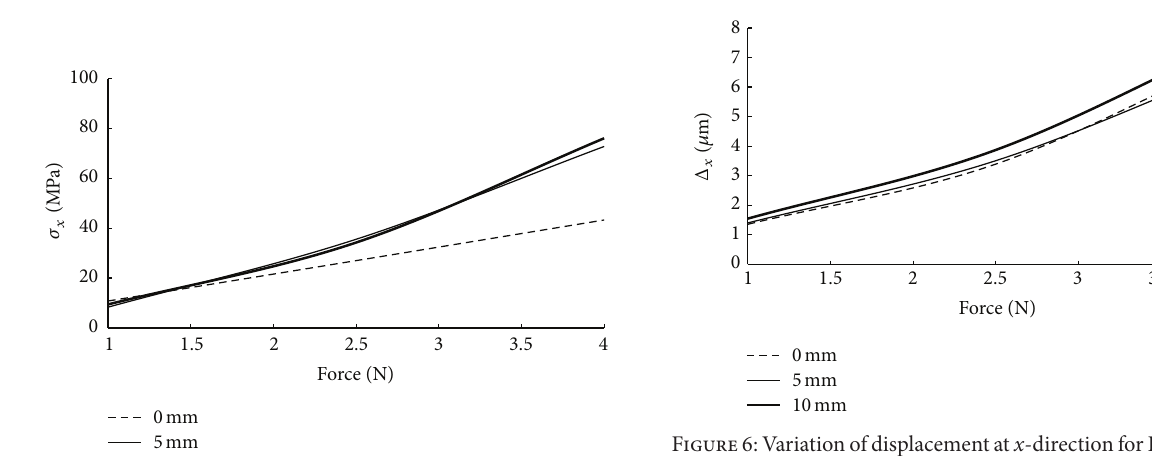
Figure 6: Variation of displacement at x -direction for FCR of Model II under the position angle of 34 ∘